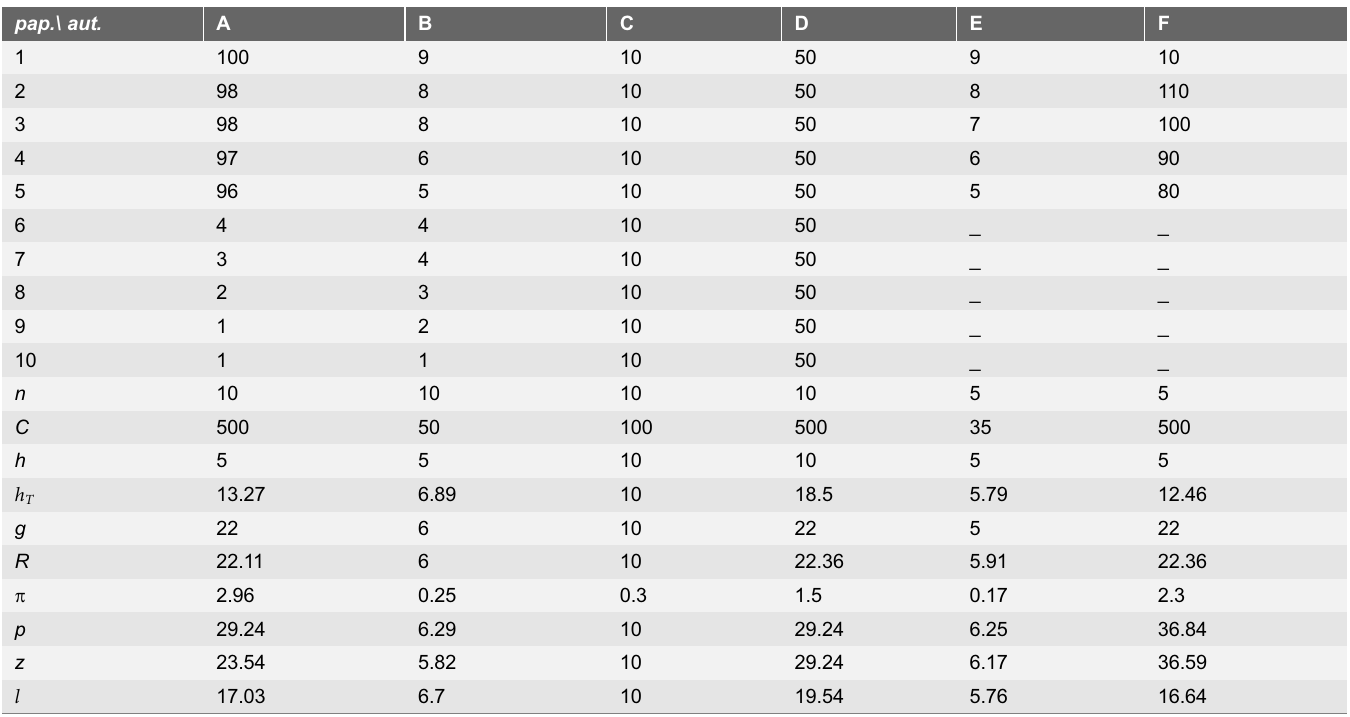
Table 1. Theoretical